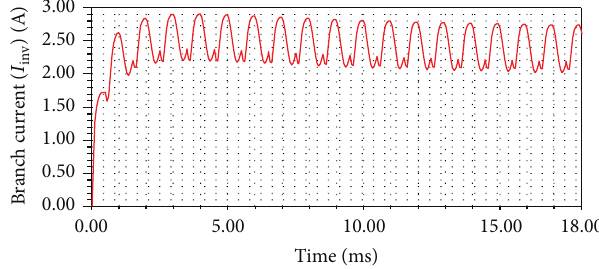
Figure 16: The leakage current (with LCL filter and capacitor bank).